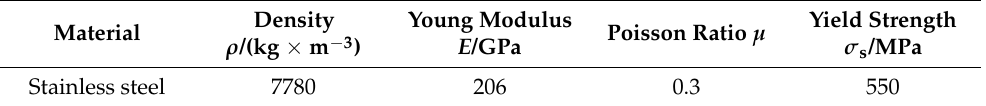
Table 1. Blade material properties.